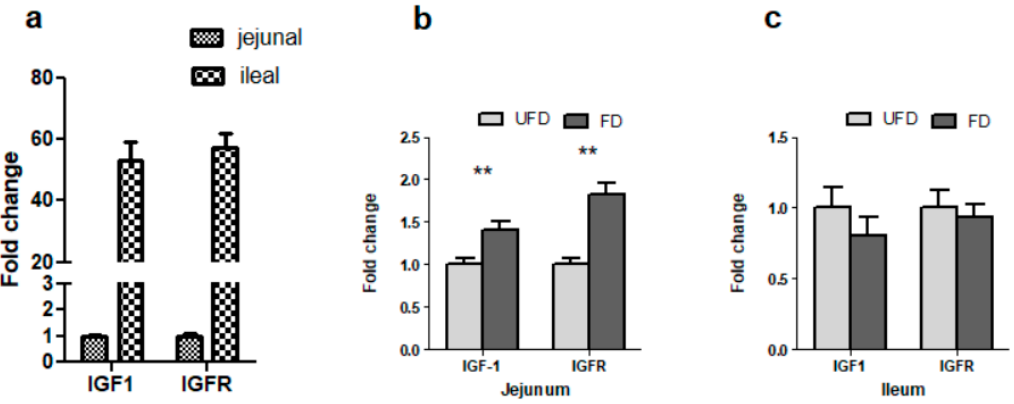
Figure 4. Relative gene expression of IGF-1 and IGFR in porcine jejunum and ileum mucosa ( a ) and effects of fermented feedstuff (FFS) on the expression of the two genes in the jejunum ( b ) and ileum ( c ) of weaned piglets. The mRNA expression was measured by real-time PCR with 5 mg of total mRNA. Glyceraldehyde 3-phosphate dehydrogenase (GAPDH) and tyrosine 3-monooxygenase/tryptophan 5-monooxygenase activation protein zeta polypeptide (YWHAZ) were used as reference genes, and the geometric mean of their Ct value was used as an internal control. The results of the feed change are shown as mean ± S.E.M. UFD: unfermented feed group; FD: fermented group. Bars with two stars denote a highly significant difference (p < 0.01).